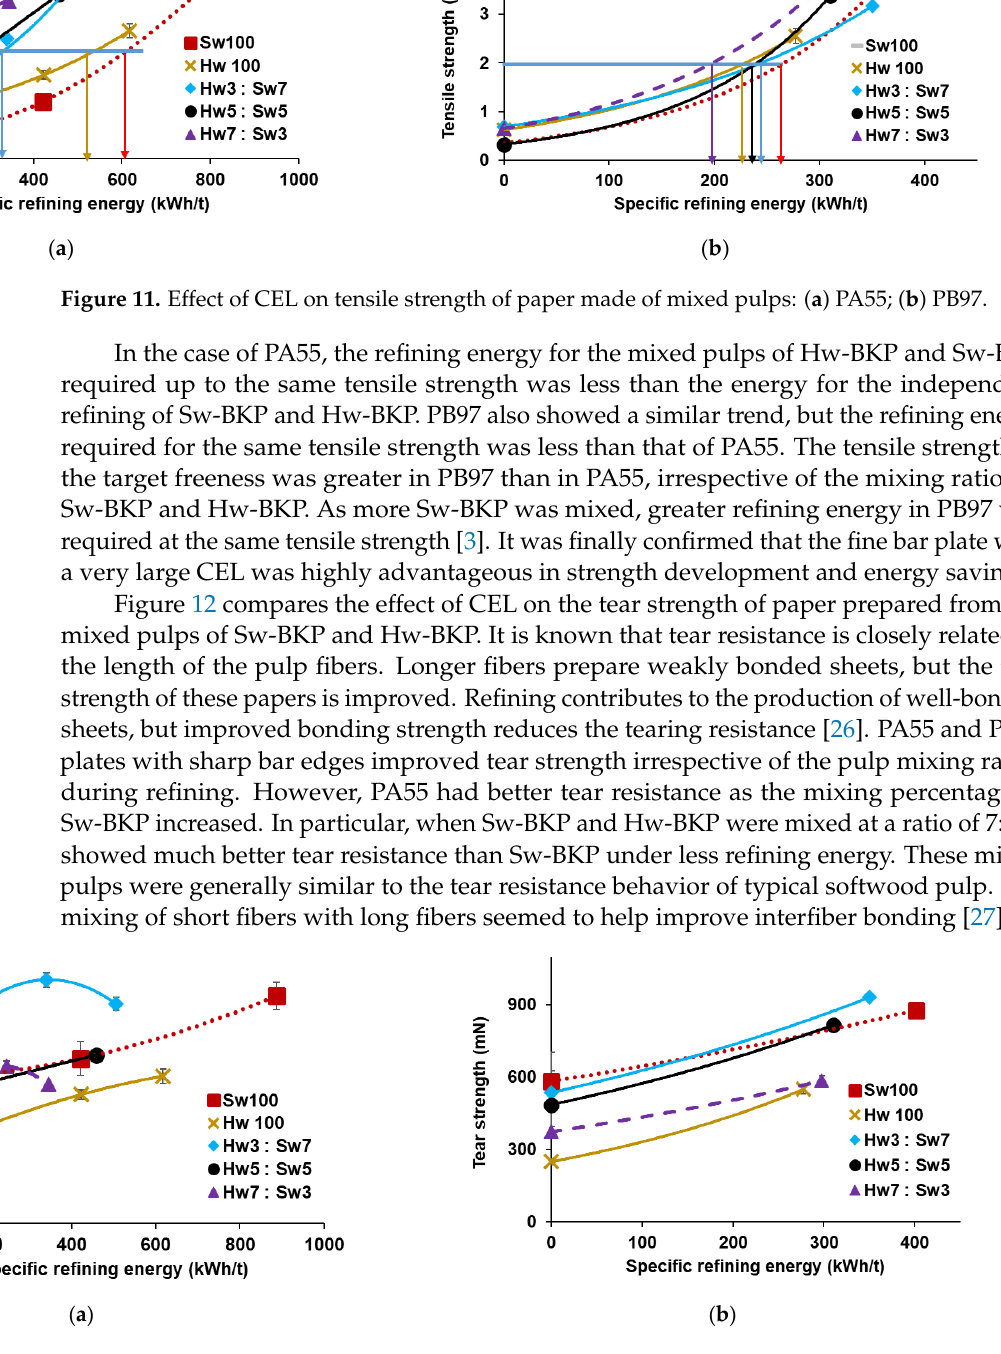
strength at the target freeness was the lowest.